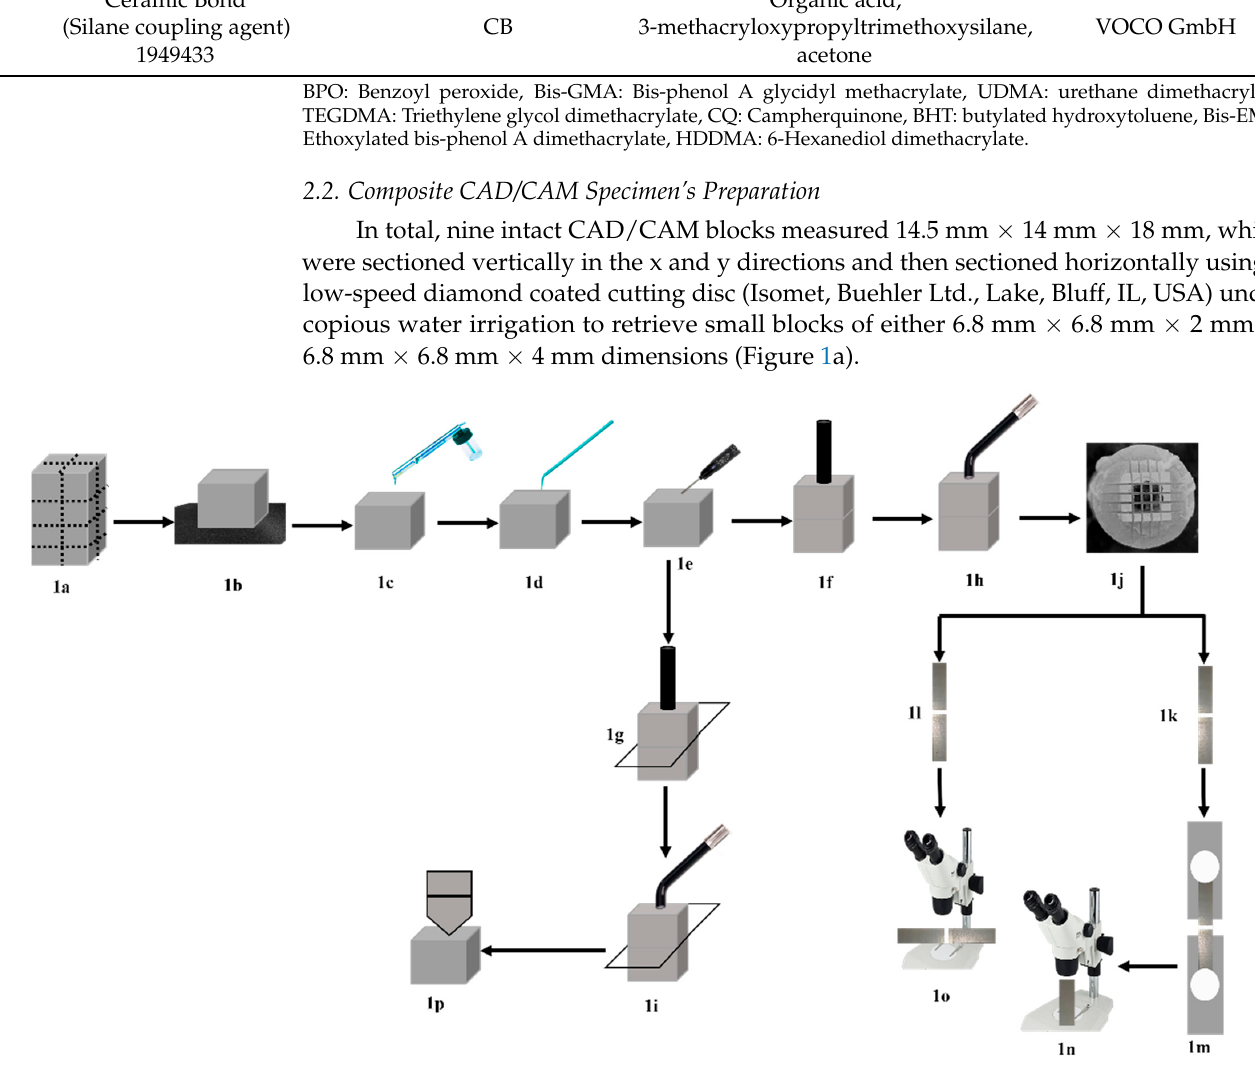
Figure 1. Schematic diagram for the experimental steps. ( a ) Cutting original CAD/CAM blocks into multiple small 6.8 mm × 6.8 mm × 2 mm and 6.8 mm × 6.8 mm × 4 mm blocks. ( b ) Surface grinding using #600 grit SiC papers. ( c ) Sandblasting of CAD/CAM surfaces/( d ) Application of silane primer. ( e ) Application of luting composites. ( f , g ) Application of 1 Kg load for the µTBS and the HV specimens. ( h , i ) Photo-polymerization of luting materials. ( j ) Cutting of bonded CAD/CAM blocks in x and y directions. ( k , l ) Obtaining 1 mm × 1 mm bonded specimens for µTBS testing and film thickness evaluation. ( m ) µTBS testing. ( n ) Evaluation of fracture mode using a stereomicroscope. ( o ) Evaluation of film thickness using the stereomicroscope. ( p ) HV testing.